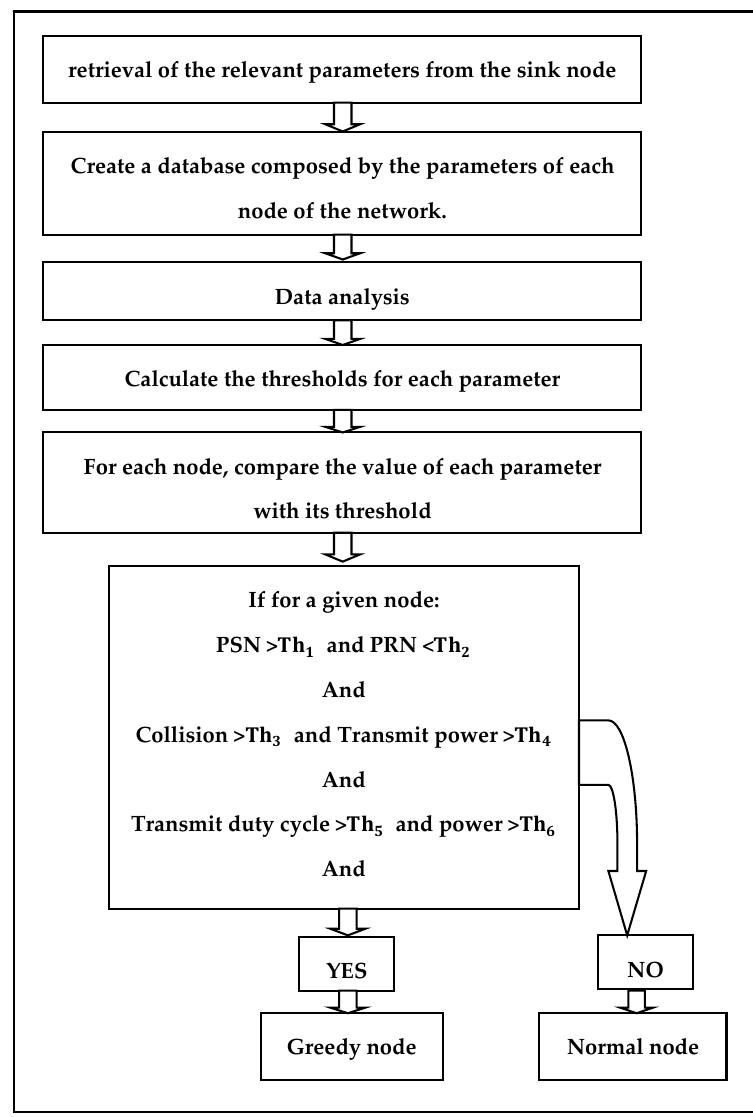
Figure 2. Greedy node algorithm identification steps.